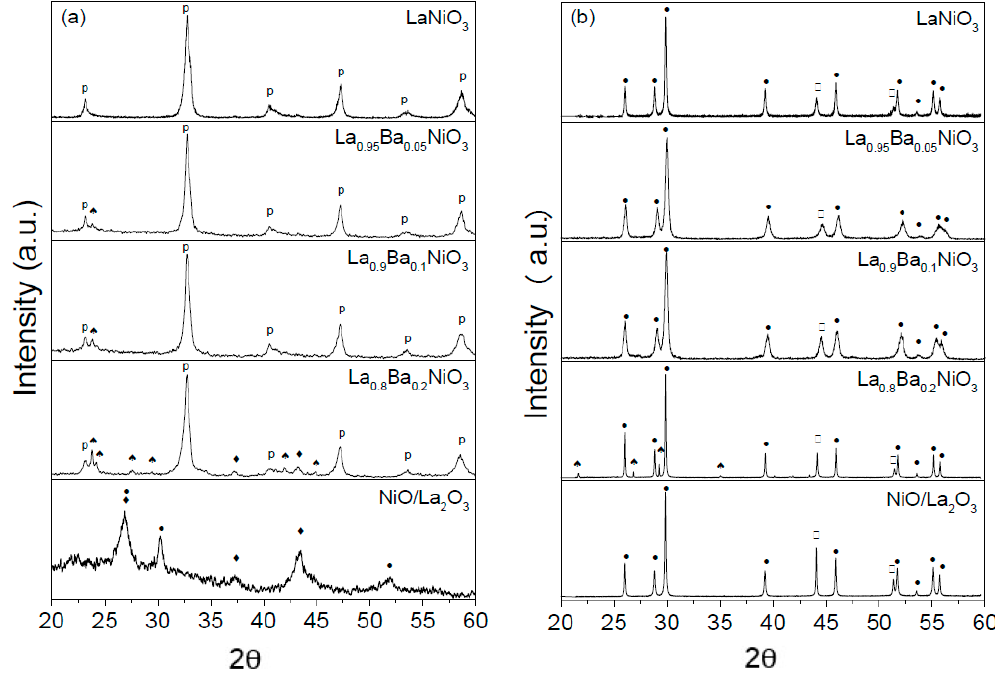
Figure 1. ( a ) X-ray diffractograms of the precursors La 1 − x Ba x NiO 3 and NiO/La 2 O 3 ( b ) X-ray diffractograms for the reduced precursor La 1 − x Ba x NiO 3 and NiO/La 2 O 3 . (p = LaNiO 3 , ♦ NiO, ● La 2 O 3 , ▫ Ni and ♠ BaCO 3 ).